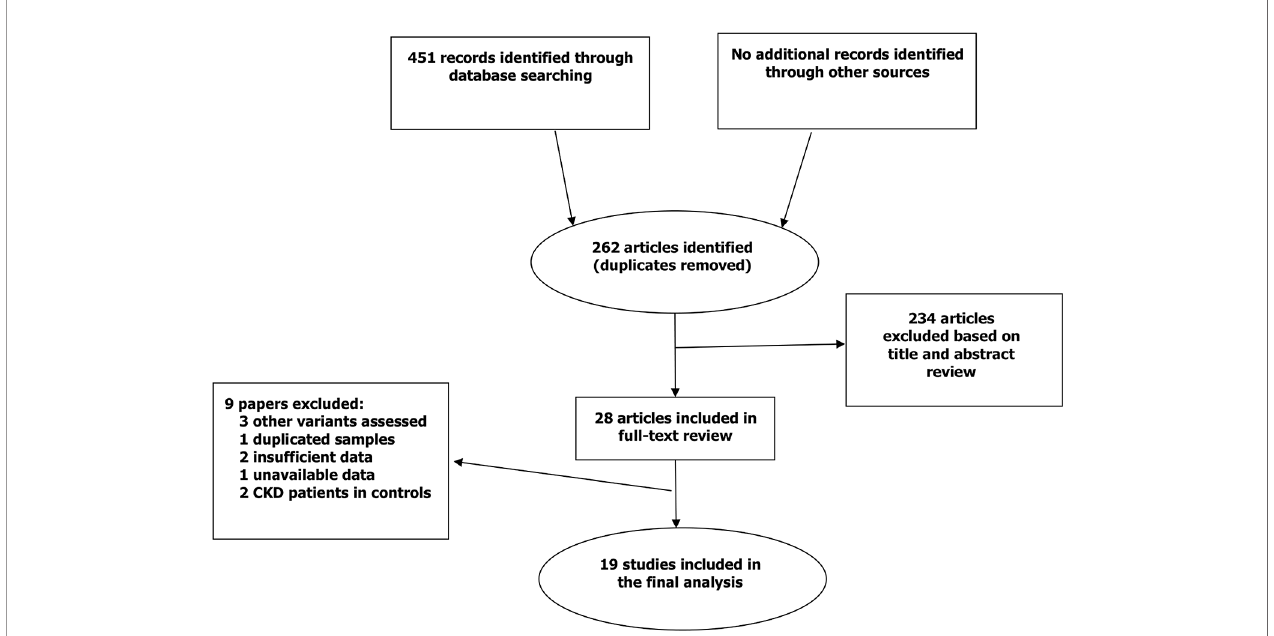
FIGURE 1 | Flow diagram of study selection and